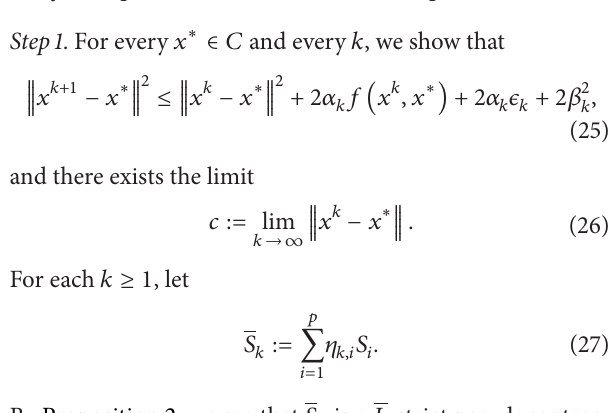
Algorithm 9. Now, the iteration scheme for finding a com- mon point in the set of solutions of problem 𝐸𝑃(𝐶, 𝑓) and the set of common fixed points of 𝐿 𝑖 -strict